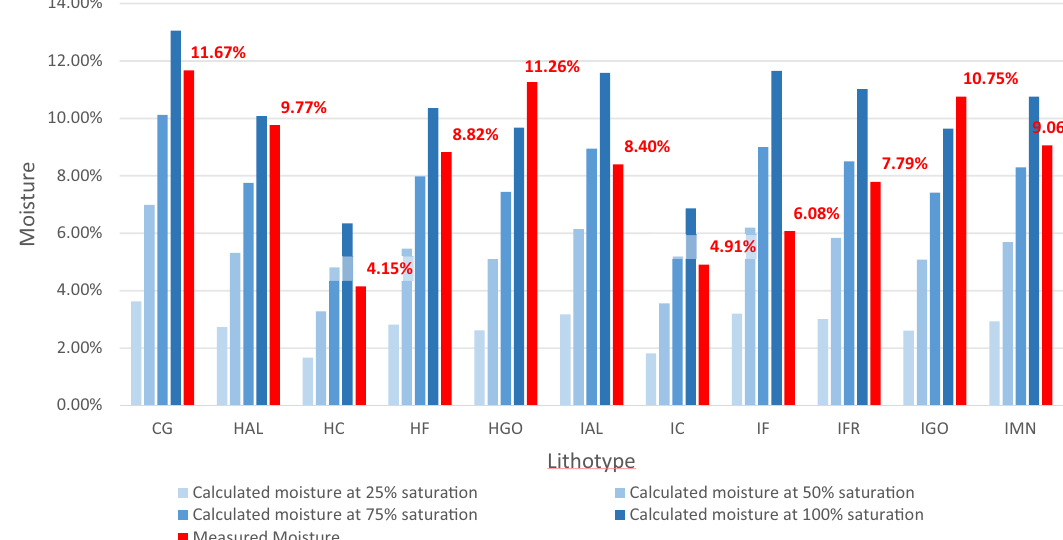
(IAL), manganiferous itabirite (IMN), high-grade soft itabirite (IFR), soft hematite (HF), compact hematite (HC), goethite–hematite (HGO), aluminous hematite (HAL) and canga (CG)